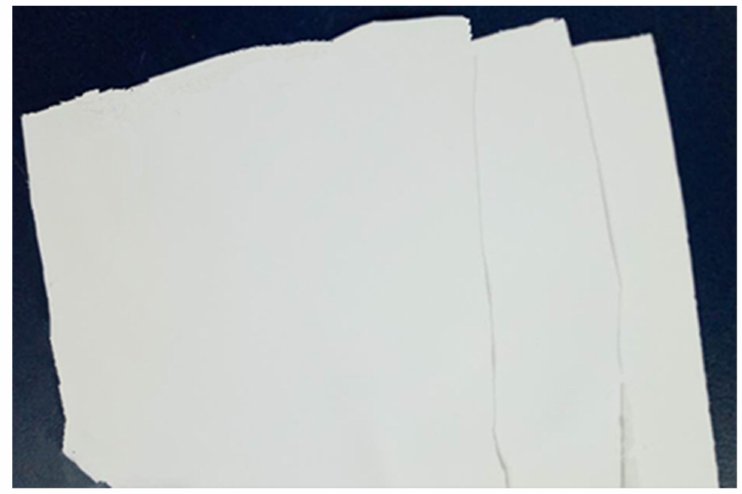
Figure 2. Panorama image of TiO 2 bifunctional